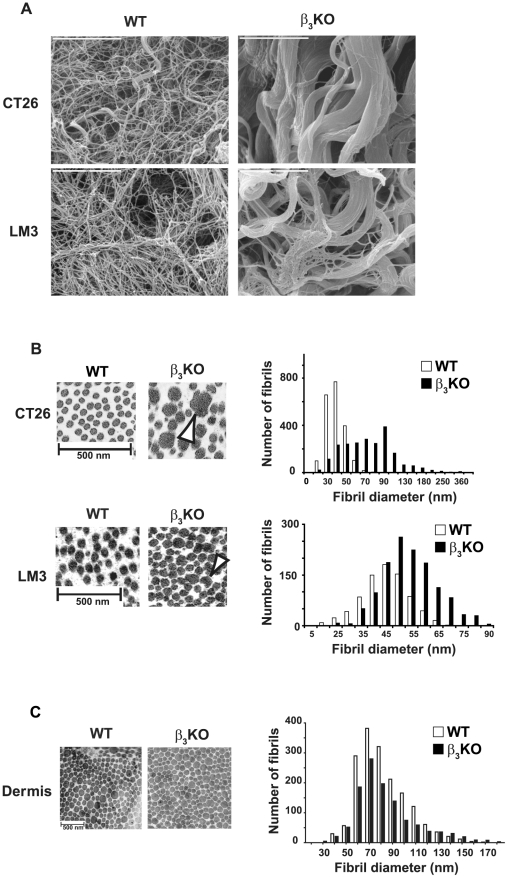
Analyses of collagen scaffold structure in CT26 and LM3 carcinomas grown in WT and integrin β3-deficient mice.
A) Representative scanning electron micrographs at ×10,000 magnification revealed thicker, fused collagen fibers in both CT26 tumors (n = 5 per genotype) and LM3 tumors (n = 3 per genotype) grown in integrin β3-deficient mice (bars = 5 µm). B) Ultrastructural analysis of CT26 tumors (n = 5 per genotype) and LM3 tumors (n = 3 per genotype). Representative transmission electron micrographs on collagen fibril morphology demonstrated a heterogeneous fibril diameter distribution in CT26 tumors and LM3 tumors (at ×15,500 and ×11,500 magnification, respectively) grown in integrin β3-deficient compared to WT mice. Some of the fibrils were laterally fused (white arrowheads) in tumors grown in β3-deficient mice (bars = 500 nm). Histogram on collagen fibril distribution in CT26 tumors grown in integrin β3-deficient (black bars; n = 2159) and WT mice (white bars; n = 2043) and in LM3 tumors from integrin β3-deficient (black bars; n = 1286) and WT mice (white bars; n = 791), showing a clear shift toward thicker fibrils in both tumor types grown in integrin β3-deficient mice. C) Representative micrographs on tail dermis collagen fibrils from WT and integrin β3-deficient mice showed similar fibril distribution between the two genotypes (n = 2; bar = 500 nm). No significant difference could be observed in collagen fibril distribution from tail dermis derived from β3-deficient (black bars; n = 1157) or WT mice (white bars; n = 1715). To analyze fibril distribution, each data point (diameter for each fibril) was tabulated in GraphPad using the Frequency distribution analysis tool.